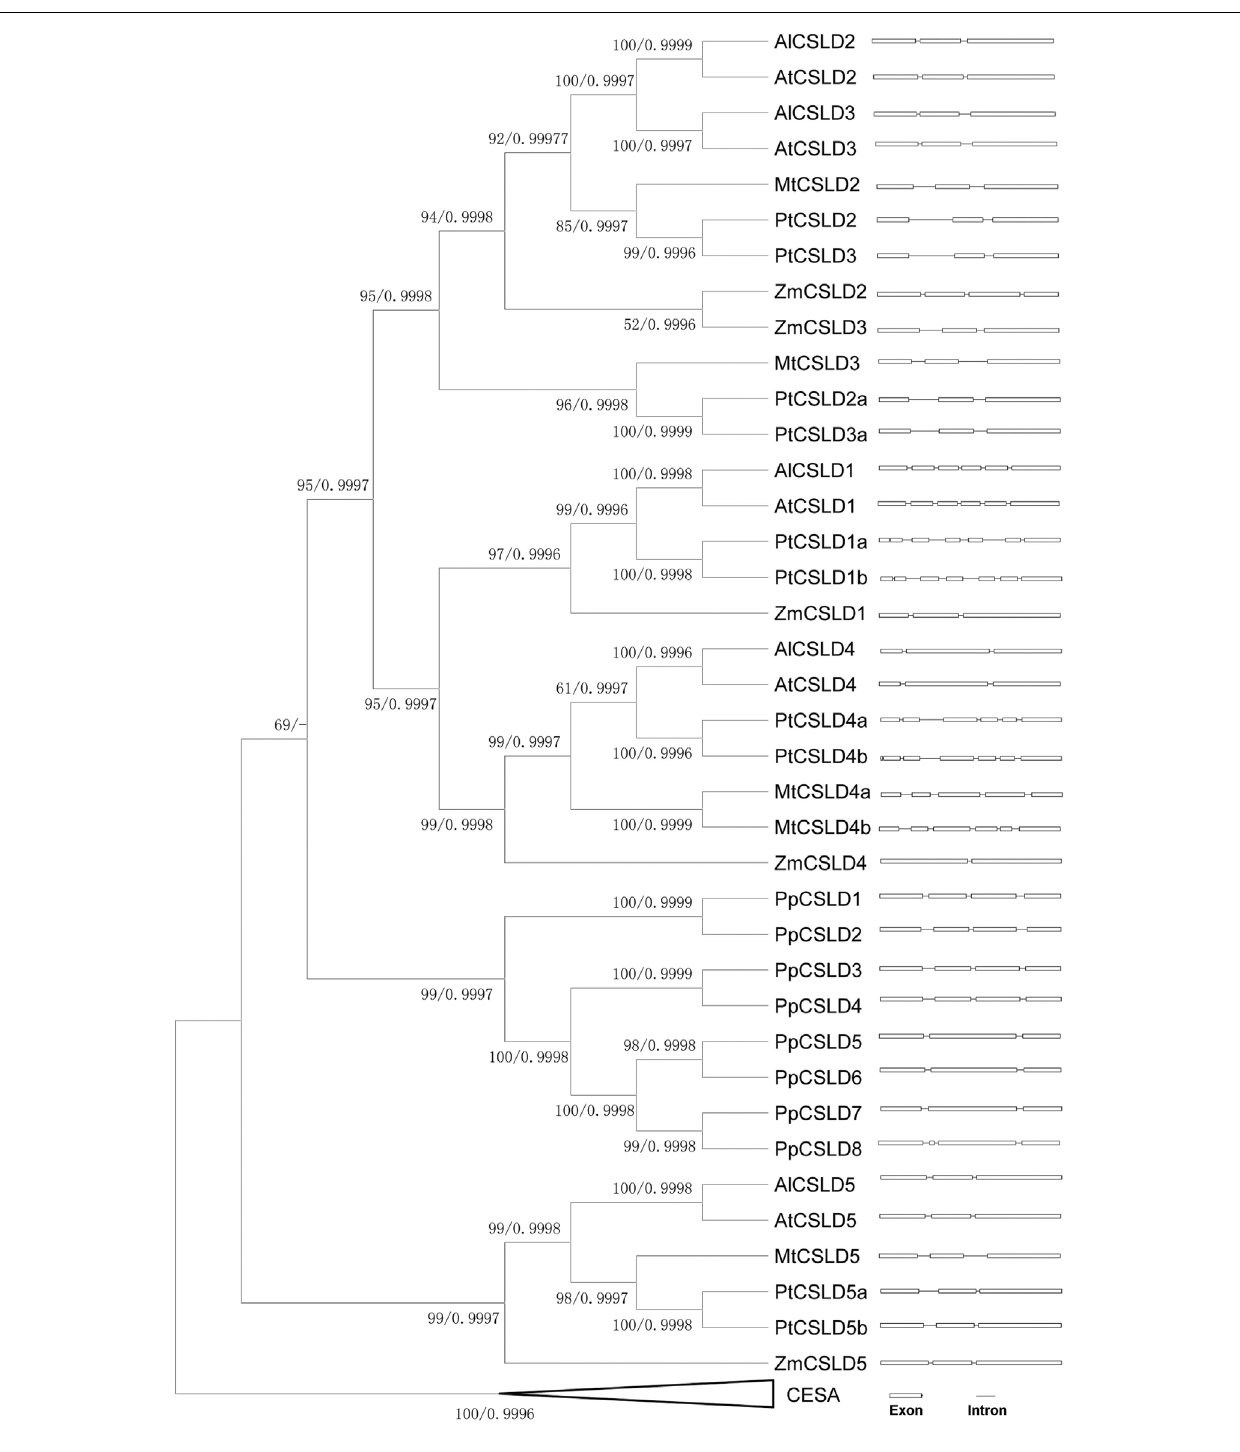
rearrangement induced by the gene trap mutagenesis strategy (Brukhin et al., 2011). Nonetheless, the fact that the partial infer- tility phenotype of csld2 csld3 can be rescued with the CSLD3